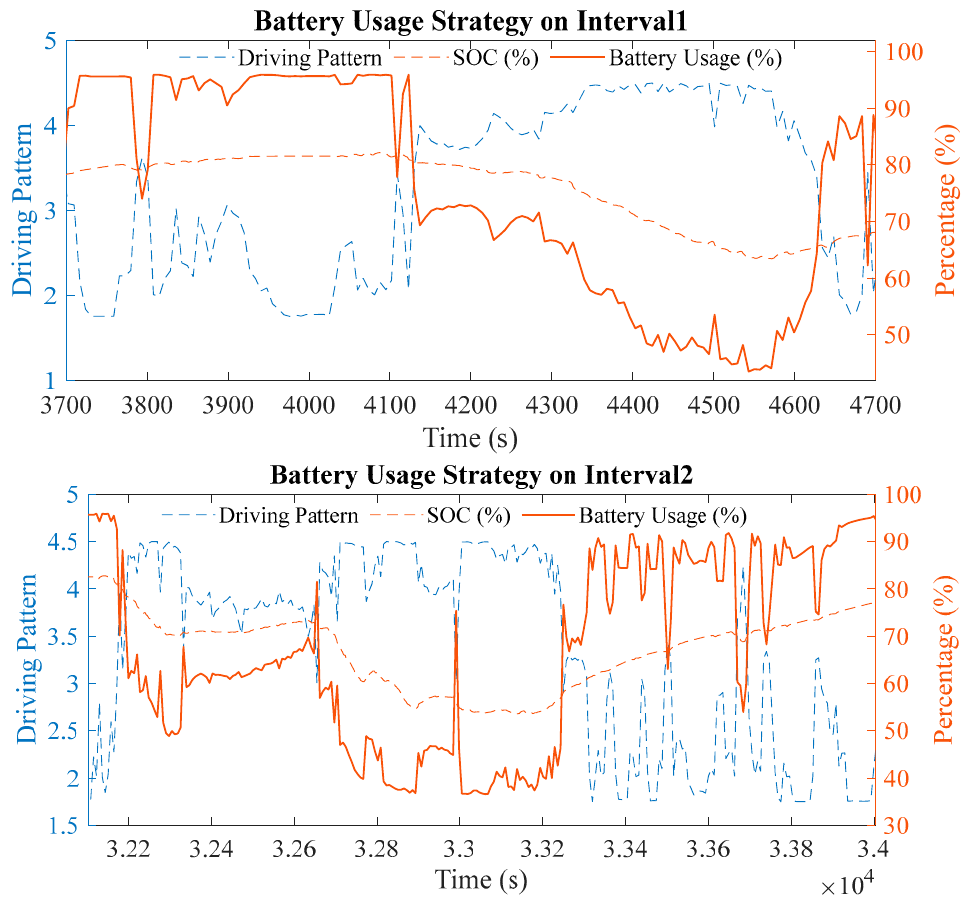
Figure 12. Battery usage strategy results.